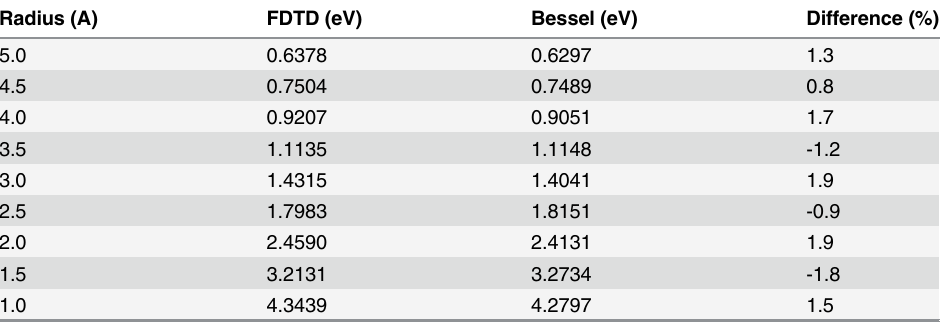
Table 1. Ground state energies for the cylindrical wire illustrated in Fig 1 for various radii as deter- mined by the FDTD method and the Bessel function